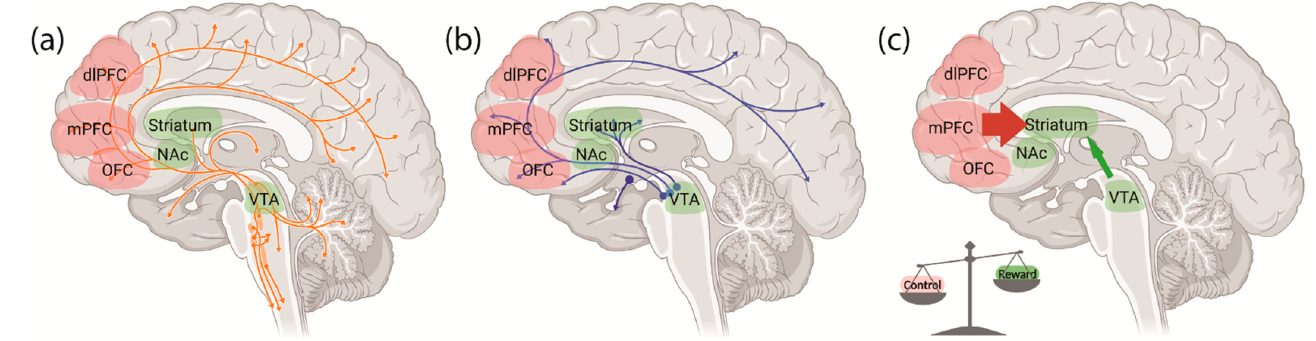
Figure 3. Neural circuits and brain areas involved in AN. ( a ) The 5-HT and ( b ) DA circuits are shown to be disrupted in patients with AN, contributing to an ( c ) imbalance between the reward and control neurocircuits in AN. The activity of prefrontal regions that are responsible for cognitive control is enhanced, while the subcortical regions that regulate reward processing are hypoactive in individuals with AN. dlPFC: dorsolateral prefrontal cortex; mPFC: medial prefrontal cortex; NAc: nucleus accumbens, OFC: orbitofrontal cortex; VTA: ventral tegmental area.